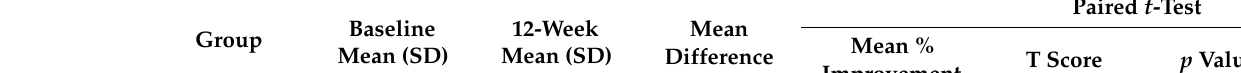
Table 1. UPDRS-MDS-III (modified) results of all participants and responders to active PBM treatment and sham